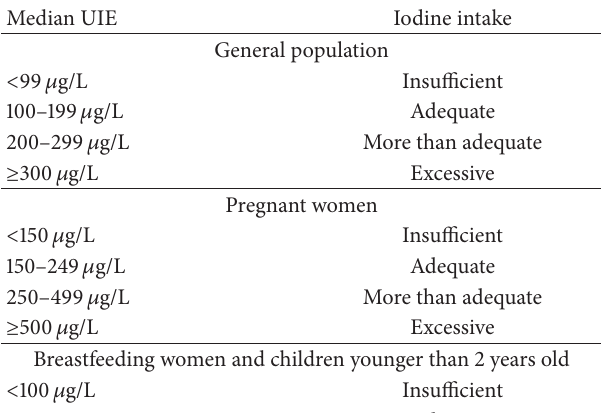
Table 2: Median UIE and iodine intake according to the WHO